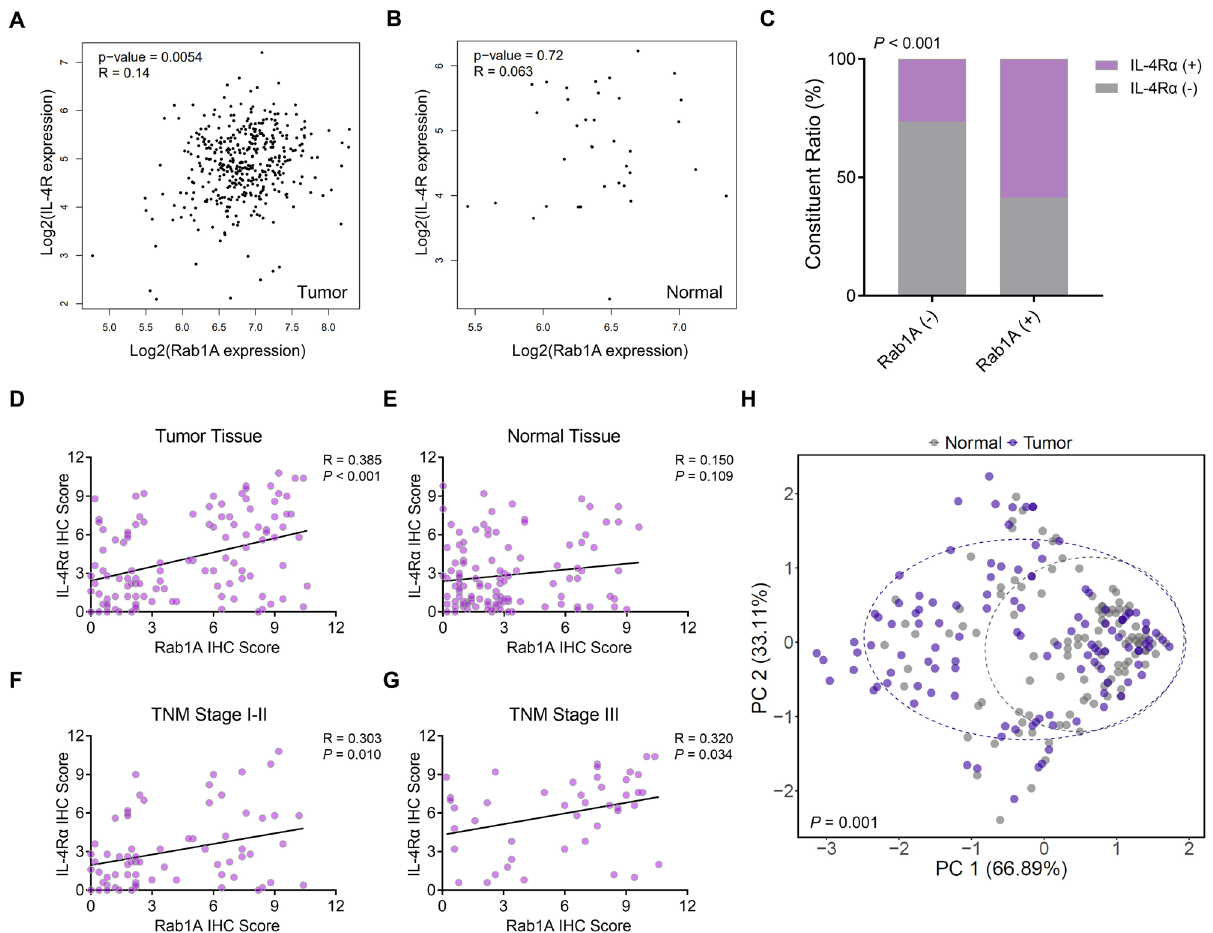
Figure 3. Association of Rab1A/IL-4Rα expression in GC. ( A , B ) the association between Rab1A/IL-4Rα expression in TCGA datasets through the GEPIA platform in GC tissues( A ) and normal tissues ( B ). ( C ) Constituent ratio depicting the correlation between Rab1A and IL-4Rα expression in GC. ( D – G ) The association of Rab1A with IL-4Rα expression using the IHC score in ( D ) GC tissues, ( E ) normal tissue, ( F ) GC with stage TNM I–II staging, and ( G ) GC with TNM III staging. ( H ) Cluster analysis of Rab1A and IL-4Rα IHC score based on GC tumor and paired normal